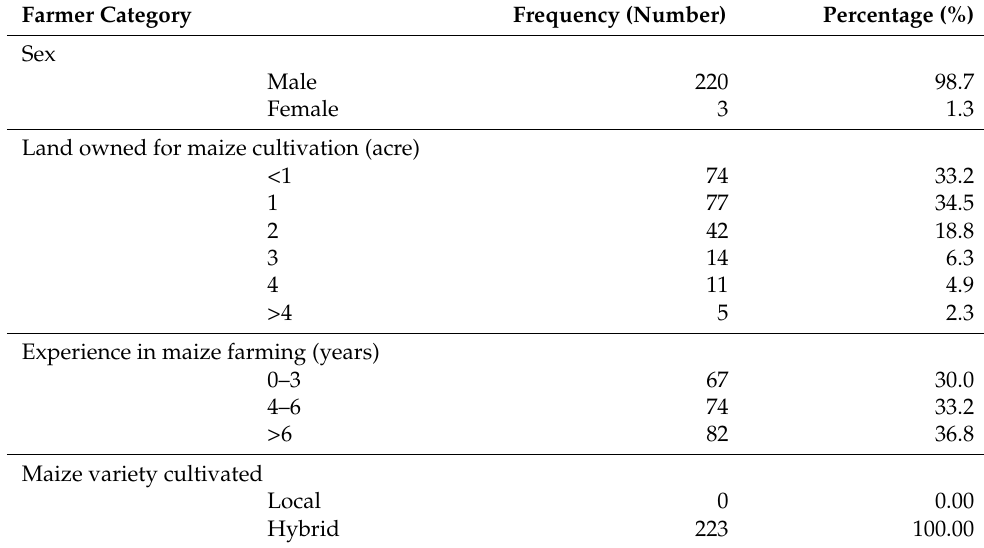
Table 2. Demographics of maize farmers in this